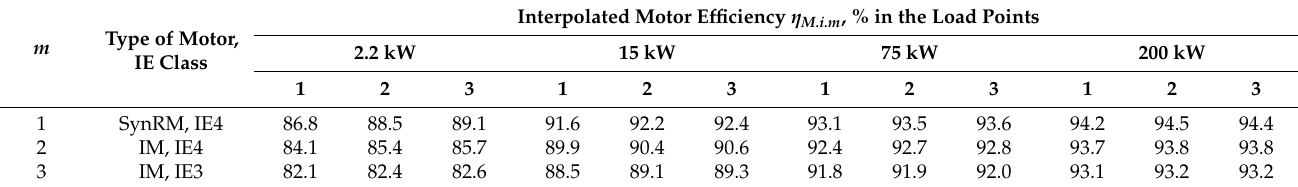
Table 5. Interpolated efficiencies of selected power drive systems.